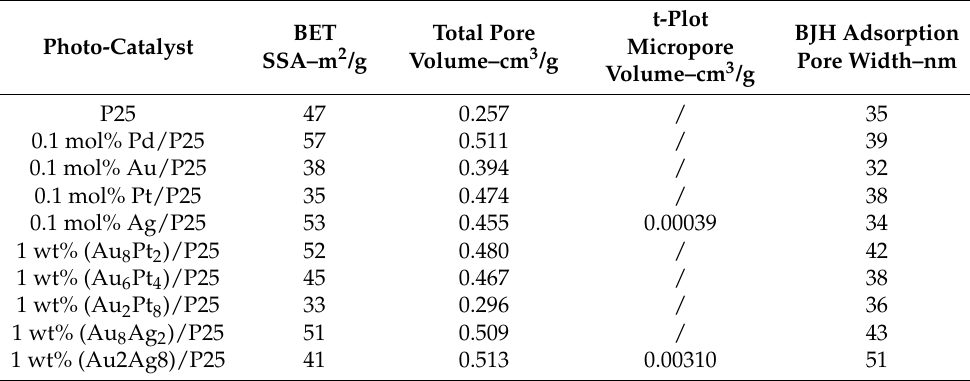
Table 2. Microstructural properties of the samples derived by N 2 sorption isotherms at − 196 ◦ C. t-Plot BET Total Pore Photo-Catalyst SSA–m 2 /g Volume–cm 3 /g